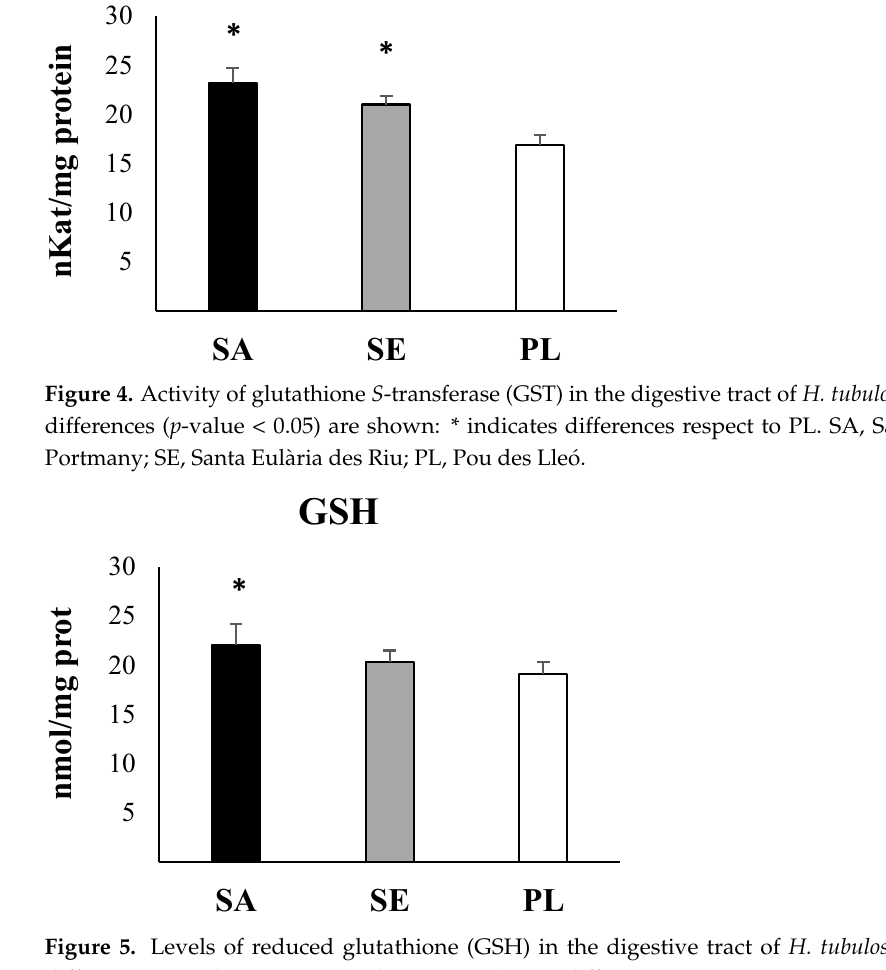
Figure 5. Levels of reduced glutathione (GSH) in the digestive tract of H. tubulosa . Significant differences ( p -value < 0.05) are shown: * indicates differences respect to PL. SA, Sant Antoni de Portmany; SE, Santa Eulària des Riu; PL, Pou des Lleó.